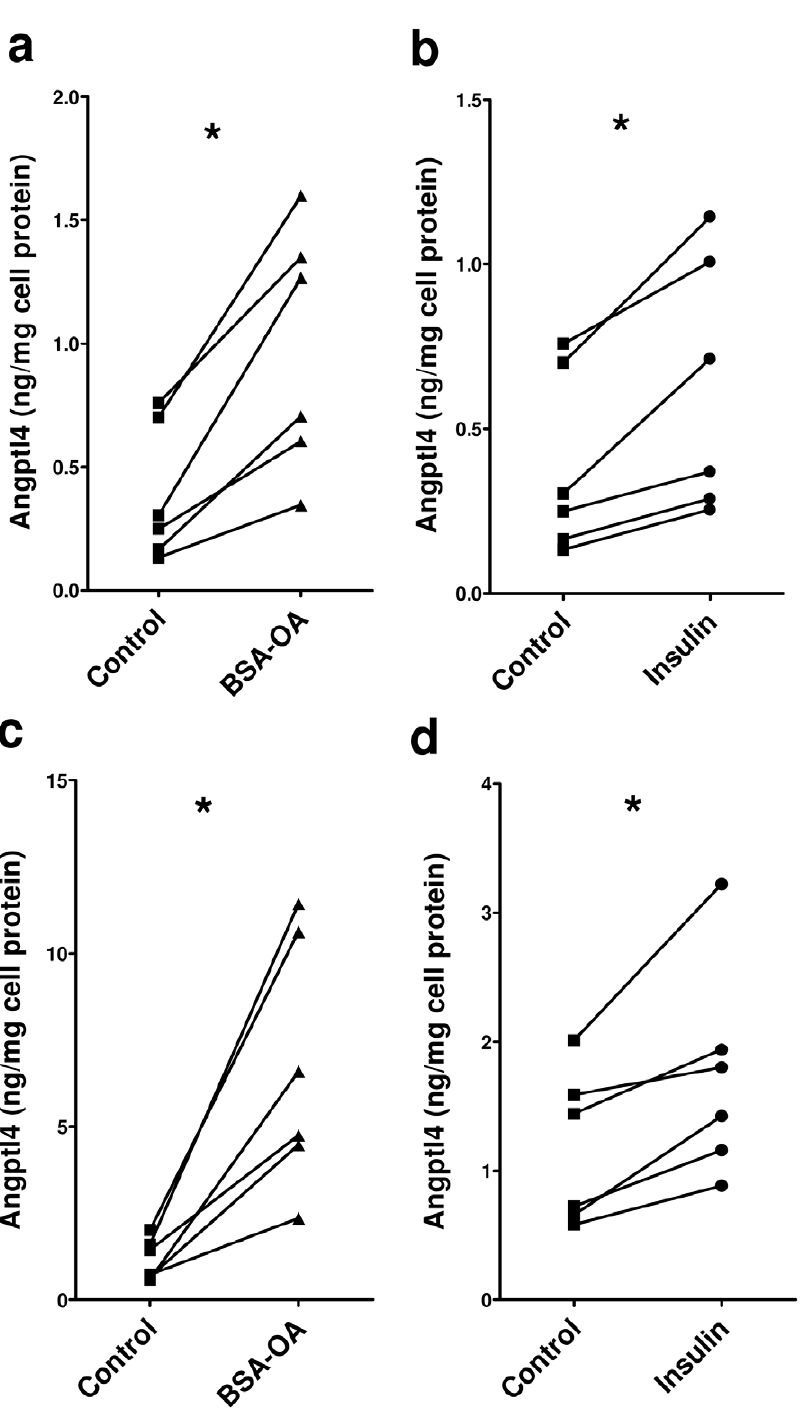
Figure 2. Angptl4 protein expression is increased by free fatty acids and insulin in human myotubes. Concentration of ( a, b ) cell associated and ( c, d ) secreted Angptl4 protein was quantified by ELISA in myotubes derived from six men and incubated in the presence of ( a, c ) BSA-bound oleic acid (OA-BSA, 0.5 mM) or ( b, d ) Insulin (100 nM) for 24 hours. *p , 0.05, paired t test compared with Control.